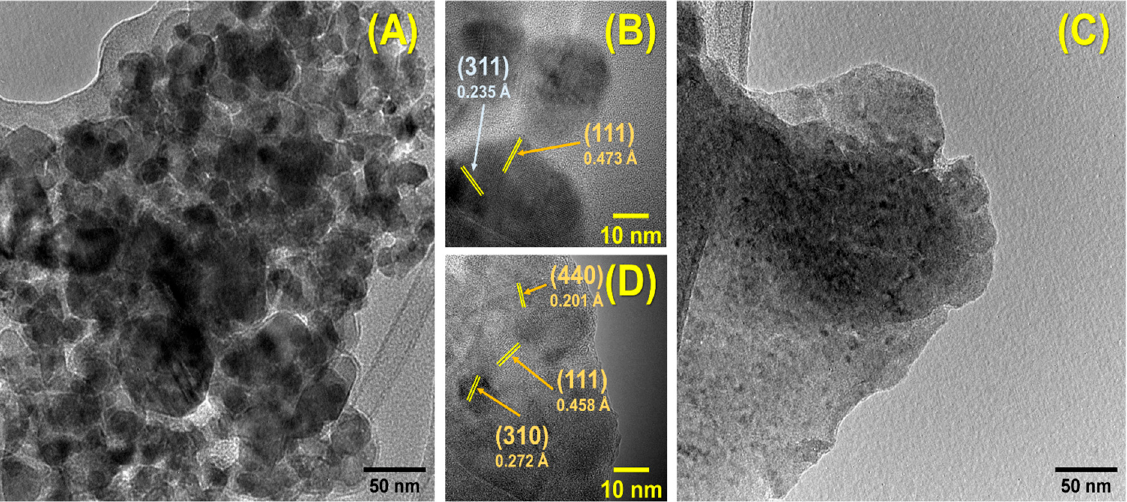
Figure 6. The TEM image of CuFe 2 O 4 samples: ( A ) 400, ( C ) 1000, ( B , D ) HRTEM image with d-space values.